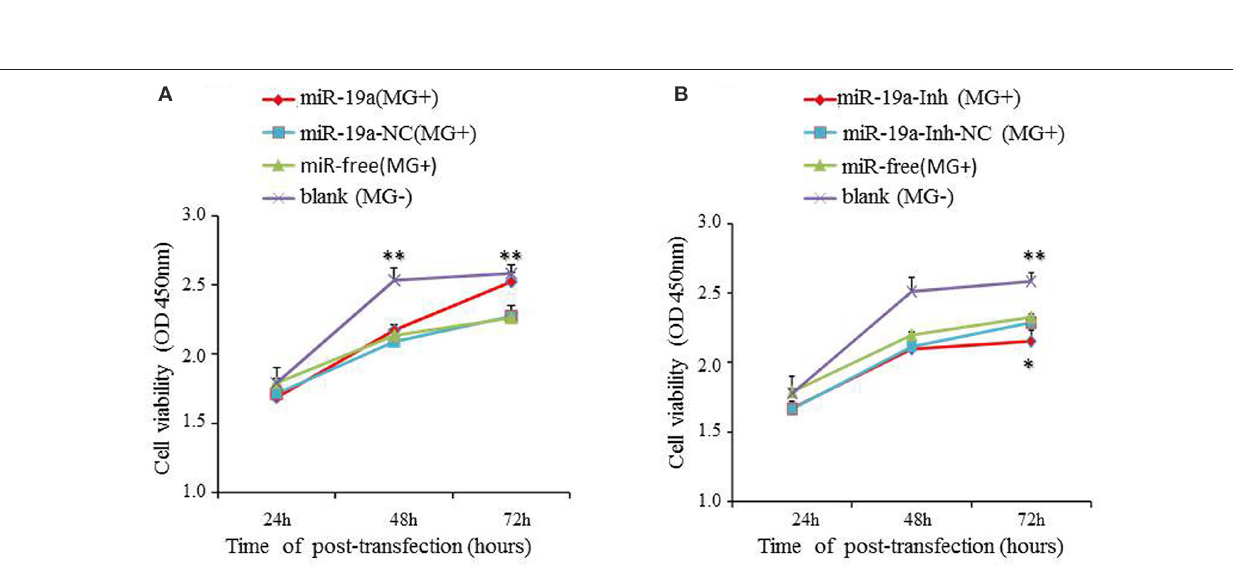
Frontiers in Cellular and Infection Microbiology | www.frontiersin.org